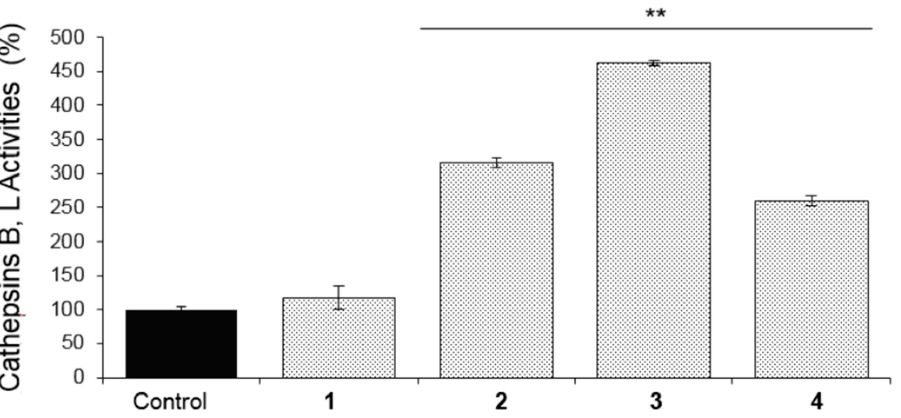
Figure 4. Relative (%) 26S proteasome activities of CT-L (LLVY / β 5) and C-L (LLE / β 1) in normal replicating (young) human fibroblasts after 24h of treatment with the compounds 1 , 2 , 3 and 4 at a concentration of 5 µ M. Bars, ± SD ( n = 3). * p < 0.05. Controls (cells treated with the vehicle / DMSO) were set to 100%.